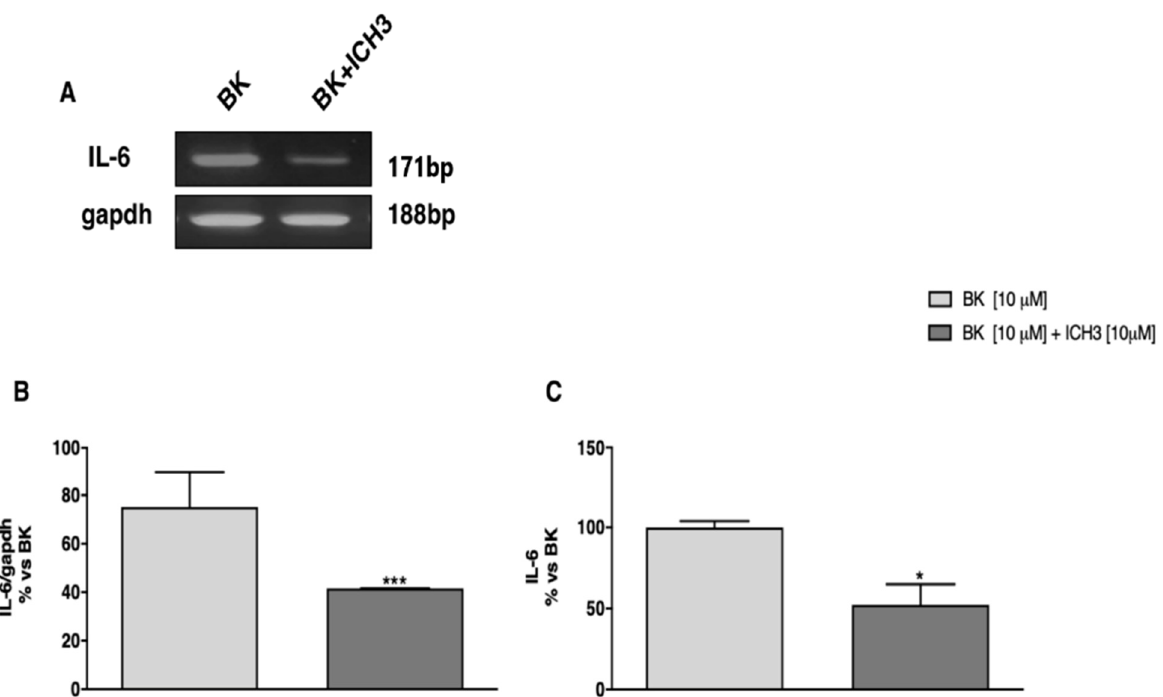
Figure 4. IL-6 expression and release upon α 7 nAChR agonist treatment. ( A ) RT-PCR analysis indicates a decrease of IL-6 transcript expression after ICH3 treatment. ( B ) Graph shows the densitometric analysis of the bands obtained from three independent experiments, normalized against the housekeeping gene, GAPDH. (n = 3; *** p < 0.001). ( C ) ELISA assay was performed on culture media of ex vivo sciatic nerves, maintained for 24 h in different experimental conditions. A significant decrease of IL-6 releases after 24 h of ICH3 exposure is detected. The analysis was performed calculating the percentage of IL-6 released/well and compared to the average of samples containing BK alone (n = 3; * p < 0.05).